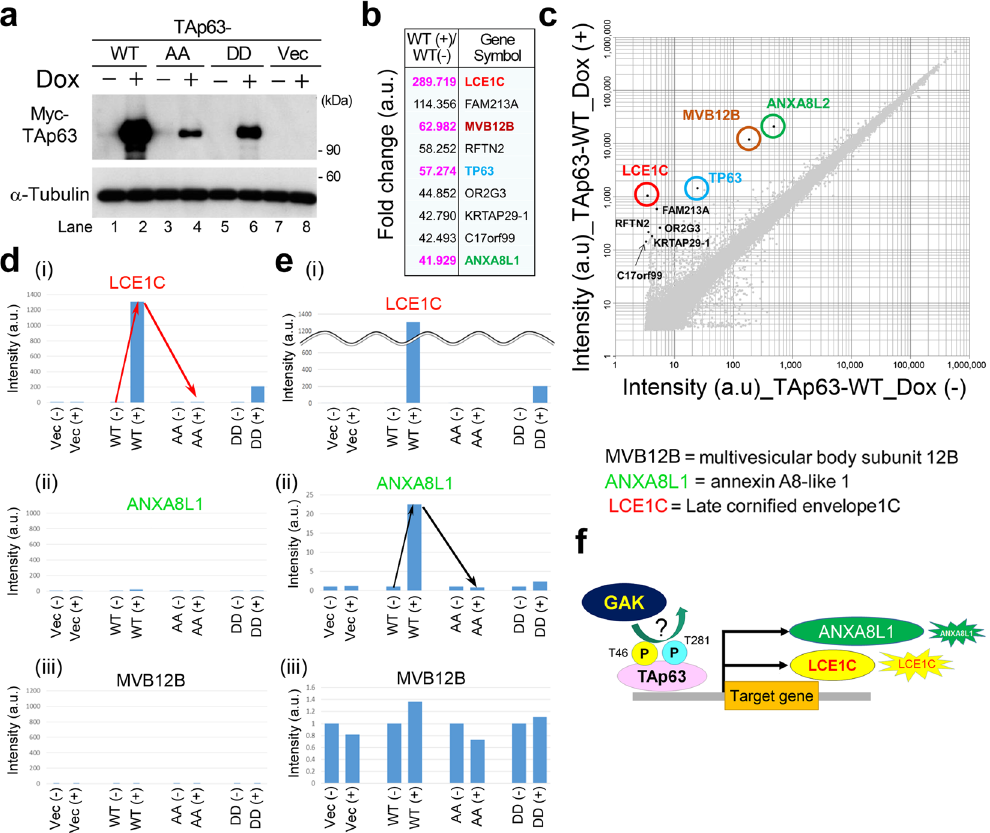
Figure 2. LCE1C is a transcriptional target of TAp63. ( a ) Wb shows that expression of Myc-TAp63 proteins drastically increased from Dox ( − ) to Dox ( + ) conditions in Tet-ON inducible Myc-TAp63-WT, Myc-TAp63- T46A/T281A (AA), or Myc-TAp63-T46D/T281D (DD) U2OS cell lines. Vec means Myc-vector alone. The amount of α -tubulin was monitored as a loading control. ( b ) List of the nine genes arranged in the descending order of averaged fold change values of signal intensity, obtained by DNA microarray analysis. ( c ) Scatter plot of the DNA microarray data for average values from Dox ( − ) versus Dox ( + ) conditions in Tet-ON inducible Myc-TAp63-WT cells. The y-axis and x-axis show log 2 [hybridization signal intensity] of microarray data from Dox ( + ) and Dox ( − ), respectively. Notable genes with high fold change values are plotted. ( d,e ) Bar graphs of qRT-PCR data show relative mRNA levels in Tet-ON inducible Myc-vector, Myc-TAp63-WT, Myc-TAp63- T46A/T281A (AA), or Myc-TAp63-T46D/T281D (DD) U2OS cell lines in Dox ( − ) and Dox ( + ) conditions for the denoted genes (i–iii). Red and black arrows highlight the notable alterations of the mRNA levels. The y-axis values are magnified in (e). ( f ) A schematic representation of the GAK_TAp63-T46/T281_LCE1C